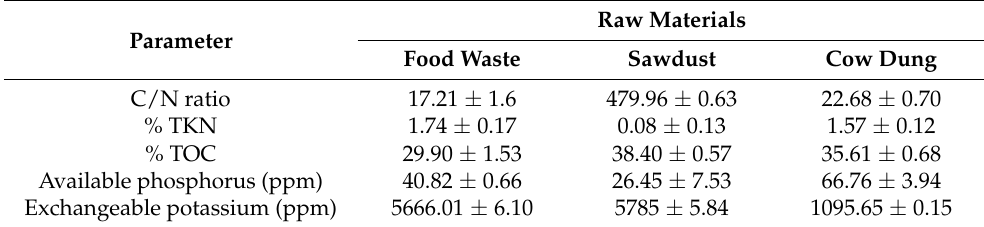
Table 2. Chemical compositions of the raw materials used in our study.